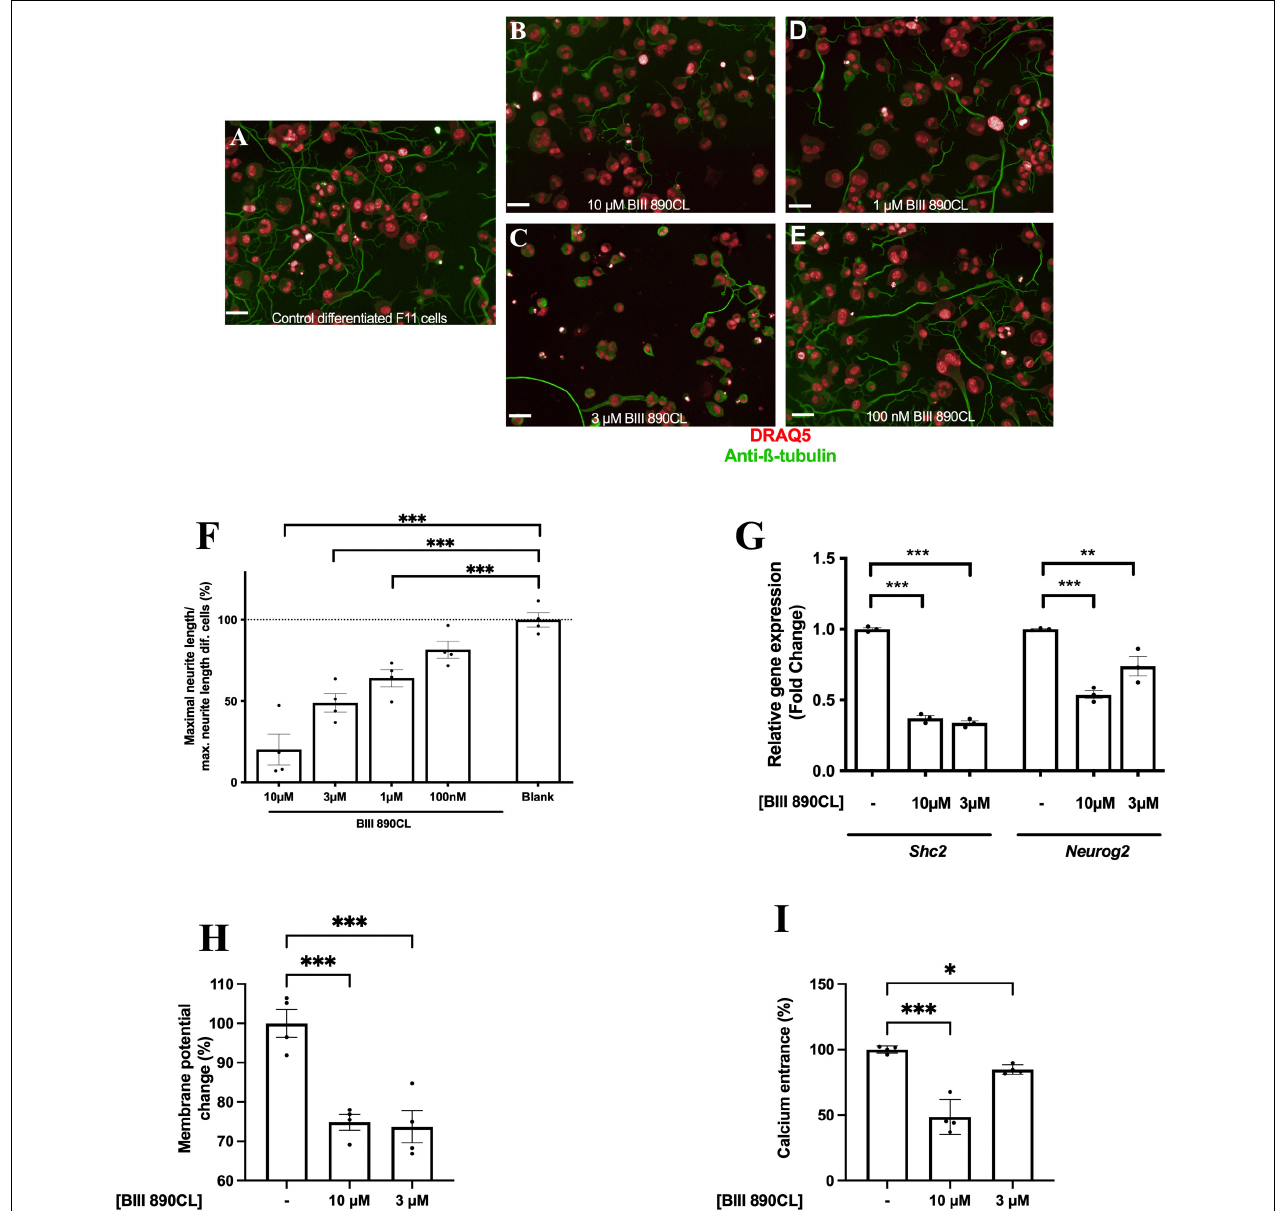
FIGURE 4 | Pharmacologic inhibition of Na V 1.5 channels induces a reduction in the acquisition of features of DRG neurons after differentiation. Representative images of (A) control differentiated F11 cells and F11 cells differentiated under exposure to (B) 10 µ M BIII 890CL, (C) 3 µ M BIII 890CL, (D) 1 µ M BIII 890CL and (E) 100 nM BIII 890CL. Images are representative of four independent assays ( n = 4) with four replicates per condition, 20X. Scale bar = 50 µ m. (F) Maximal neurite length after 3 days of differentiation of F11 cells exposed to serial concentrations of BIII 890CL and control differentiated F11 cells. Values shown for (F) are the means ± SEM of four assays ( n = 4) with four replicates per measurement. ∗∗∗ p < 0.001 (ANOVA test followed by Dunett’s post hoc analysis). (G) Comparative quantification of the expression of the Shc2 and Neurog2 genes by RT–qPCR in differentiated F11 cells in the absence and presence of 10 and 3 µ M BIII 890CL. Values shown are the means ± SD of three independent assays ( n = 3) with three replicates per measurement. ∗∗ p < 0.01; ∗∗∗ p < 0.001 (ANOVA test followed by Dunett’s post hoc analysis). (H) Membrane potential change measured with FluoVolt elicited by 30 mM KCl in differentiated F11 cells in the absence and presence of 10 and 3 µ M BIII 890CL. Values shown are the means ± SD of four independent assays ( n = 4) with three replicates per measurement. ∗∗∗ p < 0.001 (ANOVA test followed by Dunett’s post hoc analysis). (I) Intracellular calcium concentration increase elicited by 30 mM KCl in differentiated F11 cells in the absence and presence of 10 and 3 µ M BIII 890CL. Values shown are the means ± SD of four independent assays ( n = 4) with three replicates per measurement. ∗ p < 0.05; ∗∗∗ p < 0.001 (ANOVA test followed by Dunett’s post hoc analysis).